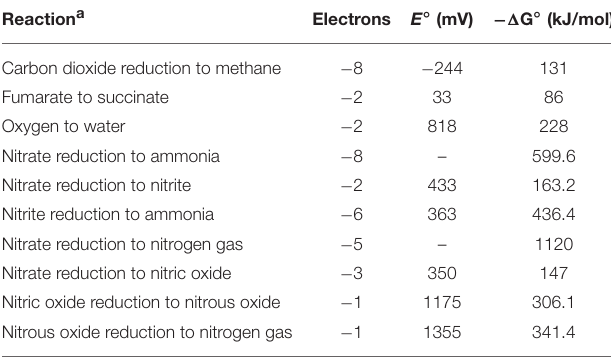
TABLE 1 | Standard molar Gibbs Free energy for reductive